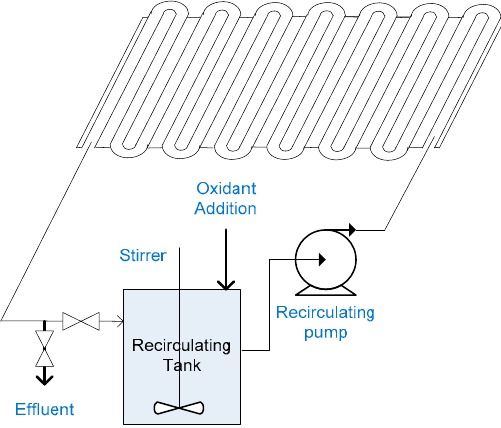
Figure 2. Schematic drawing of slurry CPC (Compound Parabolic Concentrator) system.